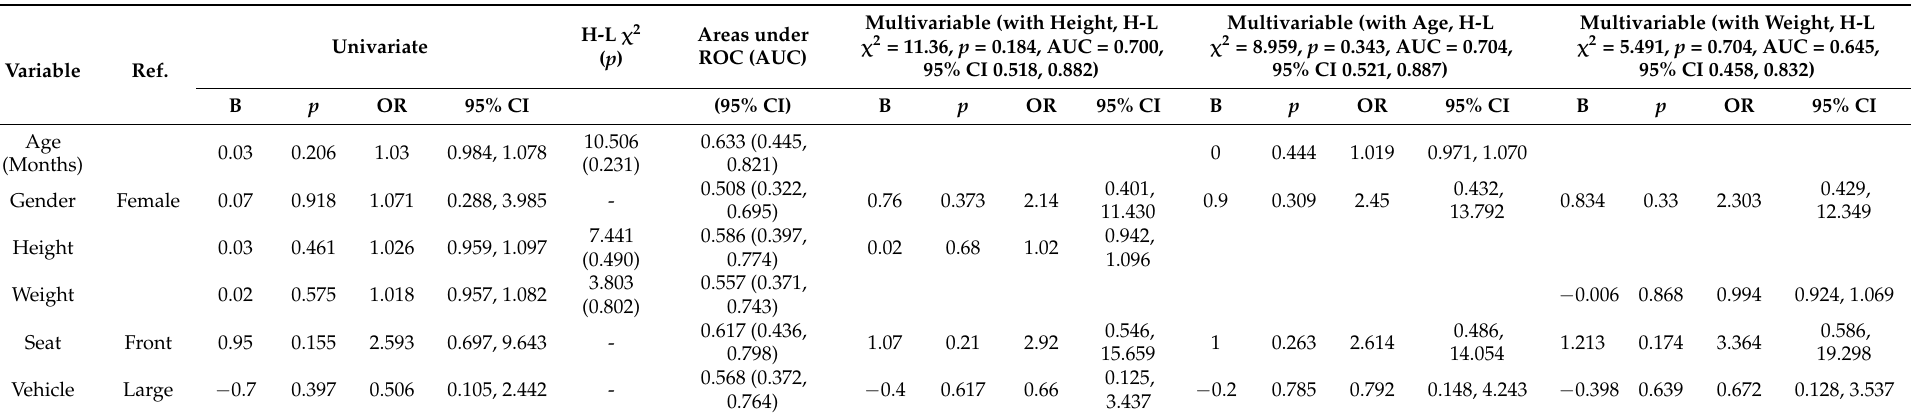
Table 2. Regression results for lap belt